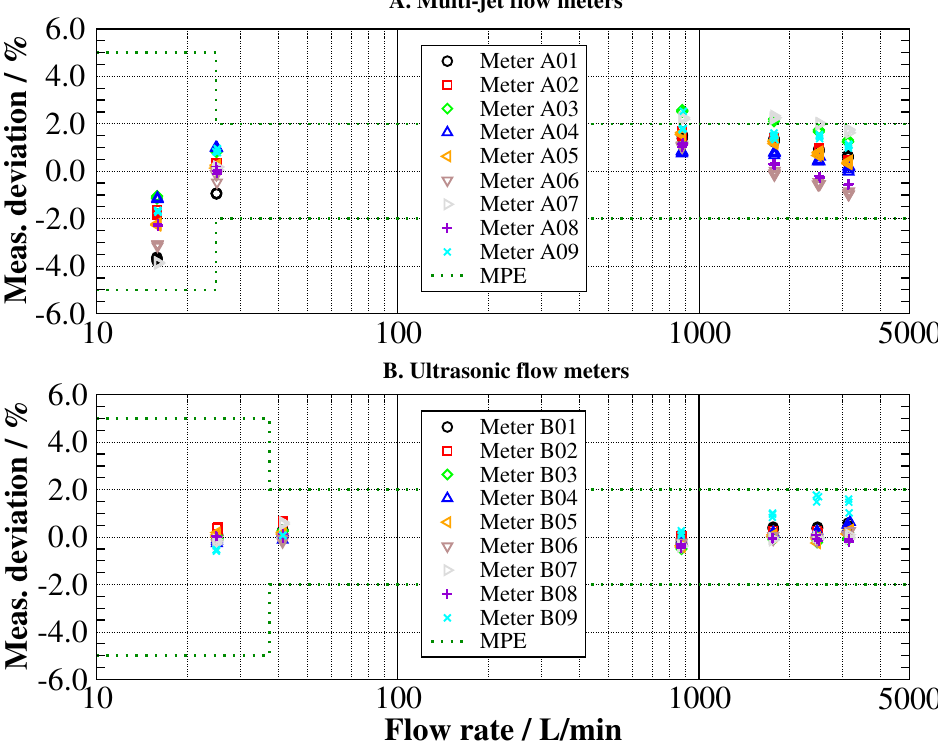
Figure 9. Top: ( A ). Calibration results of the B meters multi-jet cold water meters after the hard- ness tests; Below: ( B ). Calibration results of the Kamstrup ultrasonic cold water meters after the hardness